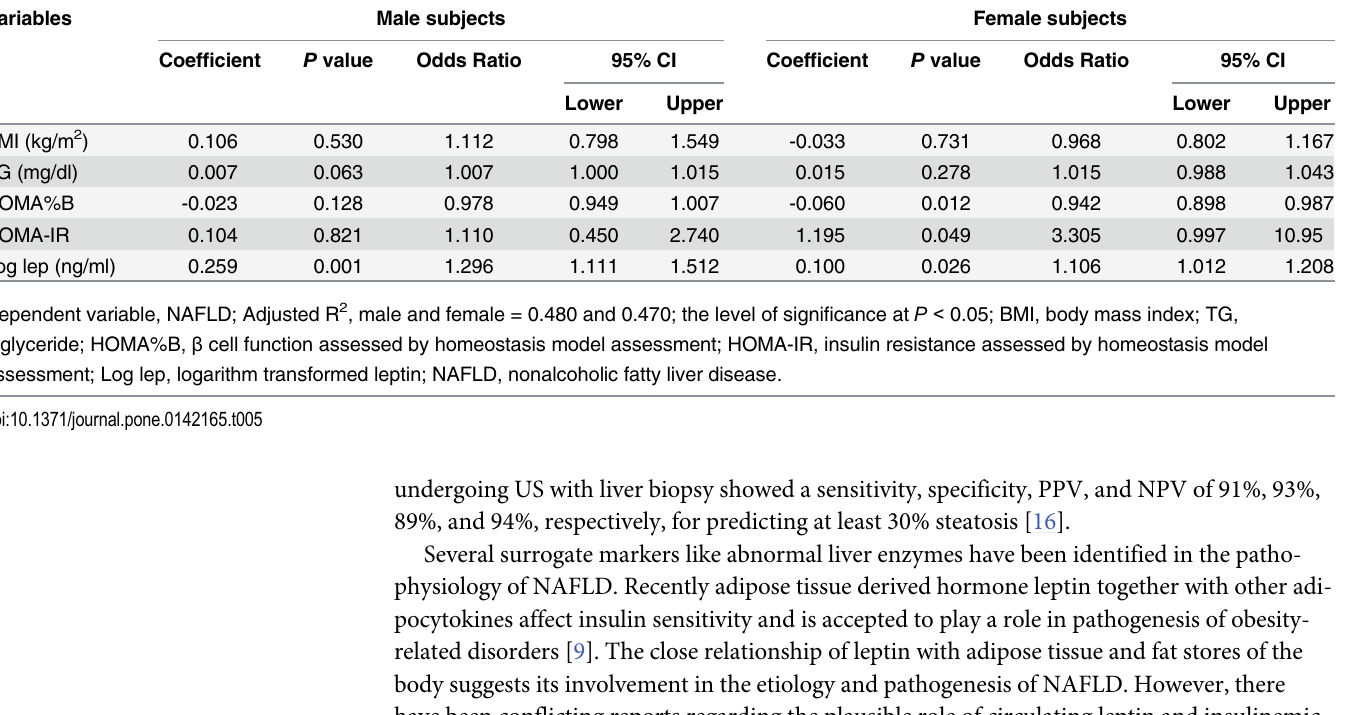
Table 5. Binary logistic regression analyses using NAFLD as the dependent variable in both genders after adjusting the major confounders. Variables Male